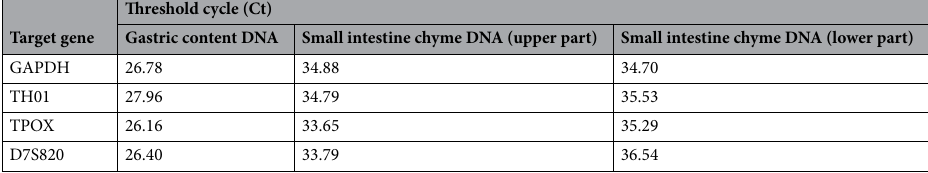
Table 5. Ct values of the four target genes from various region of digestive tract’s content of mice at 40 min after gavage.